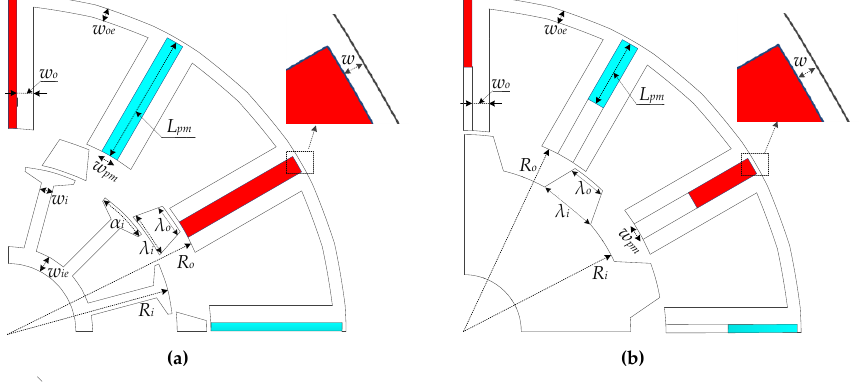
Figure 5. Design variables parametric model. ( a ) PS-HEFS1; ( b ) HEFS1.